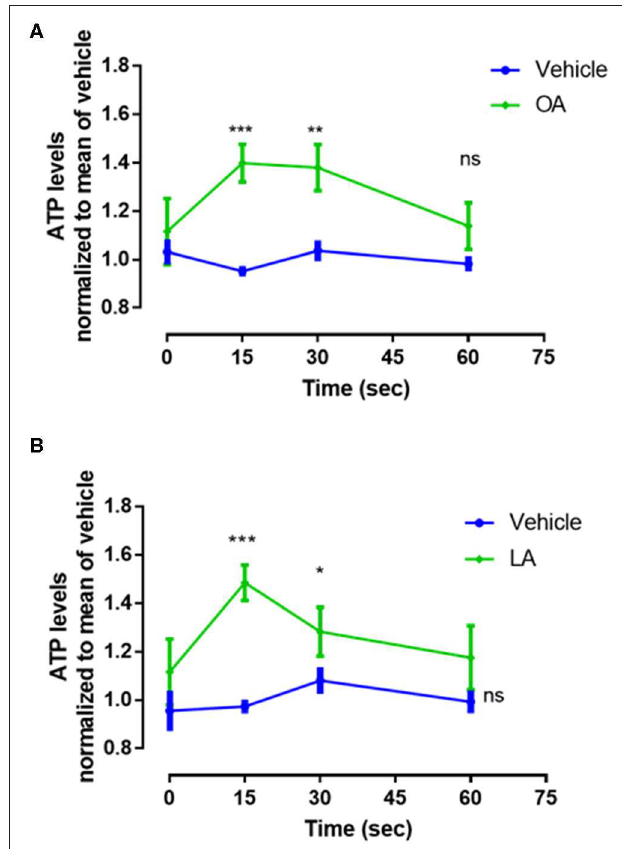
FIGURE 2 | Oleic acid (OA) and linoleic acid (LA) induce ATP release. Levels of released ATP in supernatants of PMN treated with a 200 µ M concentration of OA (A) or LA (B) for 0, 15, 30, and 60s. The data were normalized using the mean of 60s of measurement of control group. n = 4; * p < 0.05, ** p < 0.01, *** p < 0.001 compared with vehicle